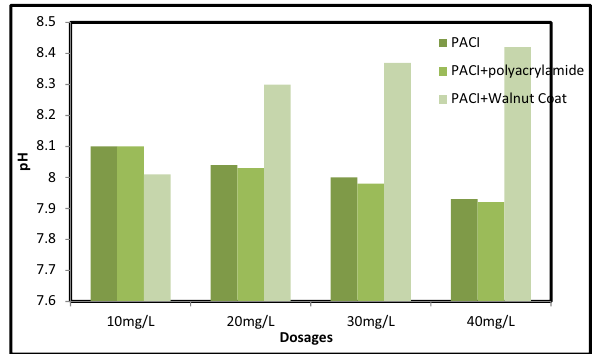
Figure 8: The relation between pH values and coagulant and its aids for samples at a water column height of 60 cm.